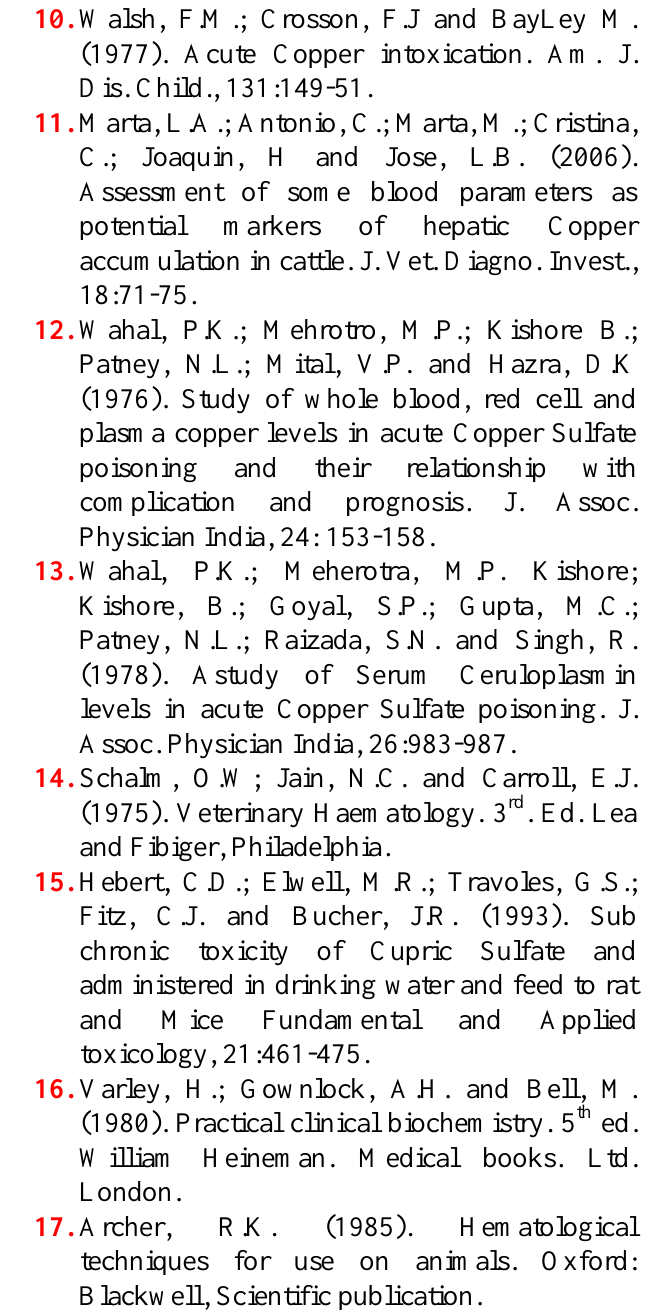
Different small letters means significant (P<0.05) results between months Different big letters means significant (P<0.05) results between group.